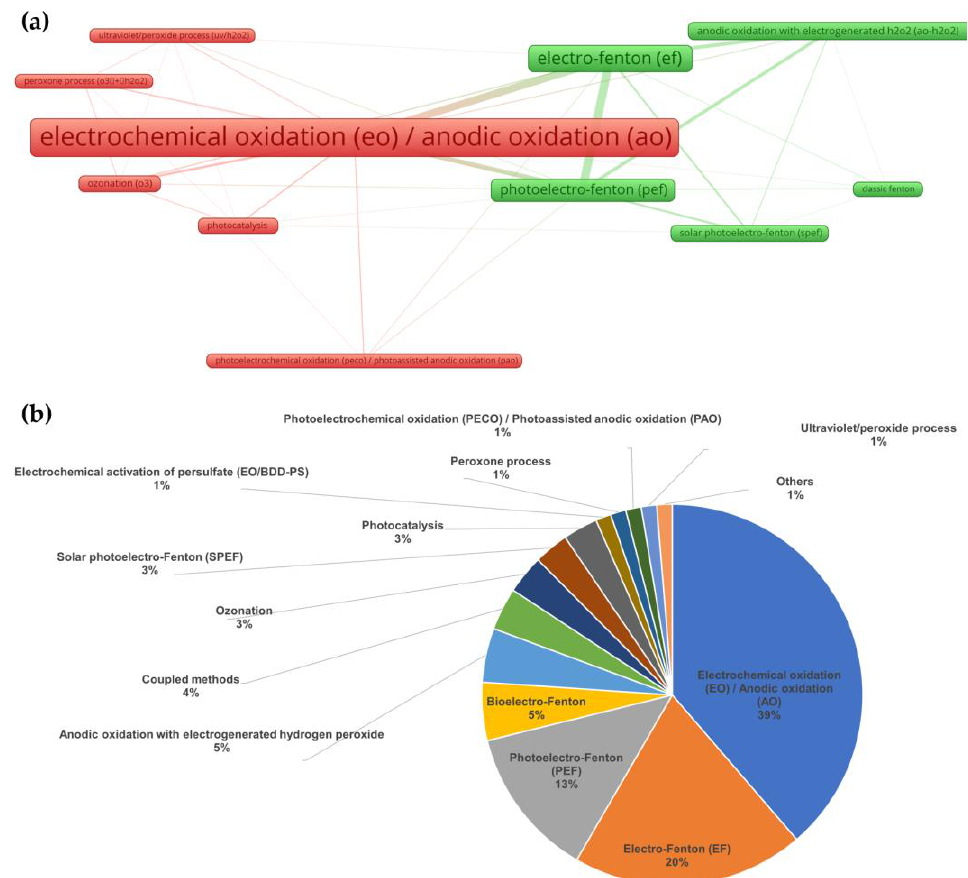
Figure 10. ( a ) EAOPs co-occurrence network (minimum of two occurrences) representation on the application of diamond electrodes for water treatment, based on the VOSviewer bibliometric mapping software [55,56]; ( b ) Distribution data on EAOPs applied in the publications selected by the SLR, based on the Scopus database (source: the authors).